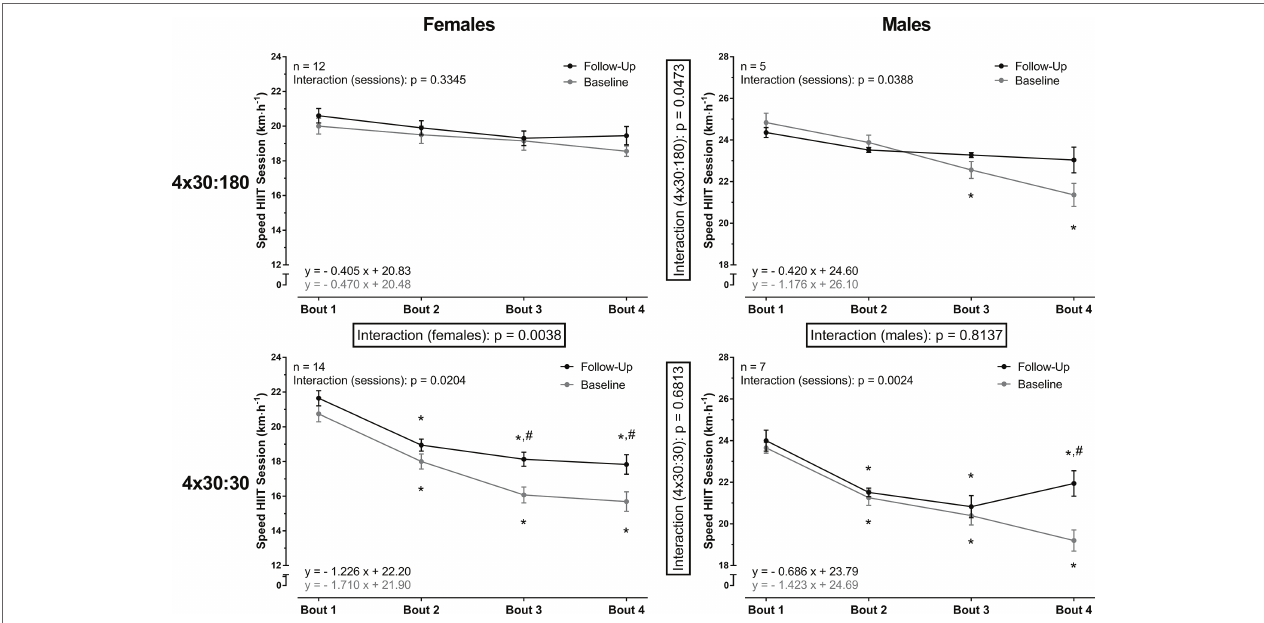
FIGURE 1 | Repeated high-intensity running performance by HIIT protocol and sex. Significant differences were detected for high-intensity running performance between females and males. Females in the 4 × 30:180 group showed no change in speed decrement or running performance at respective bouts. Repeated- measures two-way ANOVA was used to detect interaction effects for change in speed decrement (boxed) and running performance overall bouts. One-way ANOVA was performed where indicated to analyze within-session (* p < 0.05, compared to the first running bout) and between-session ( # p < 0.05, comparison of respective bouts at baseline and follow-up) differences. Data are presented as mean ± SEM. Linear regression equations are given in each respective